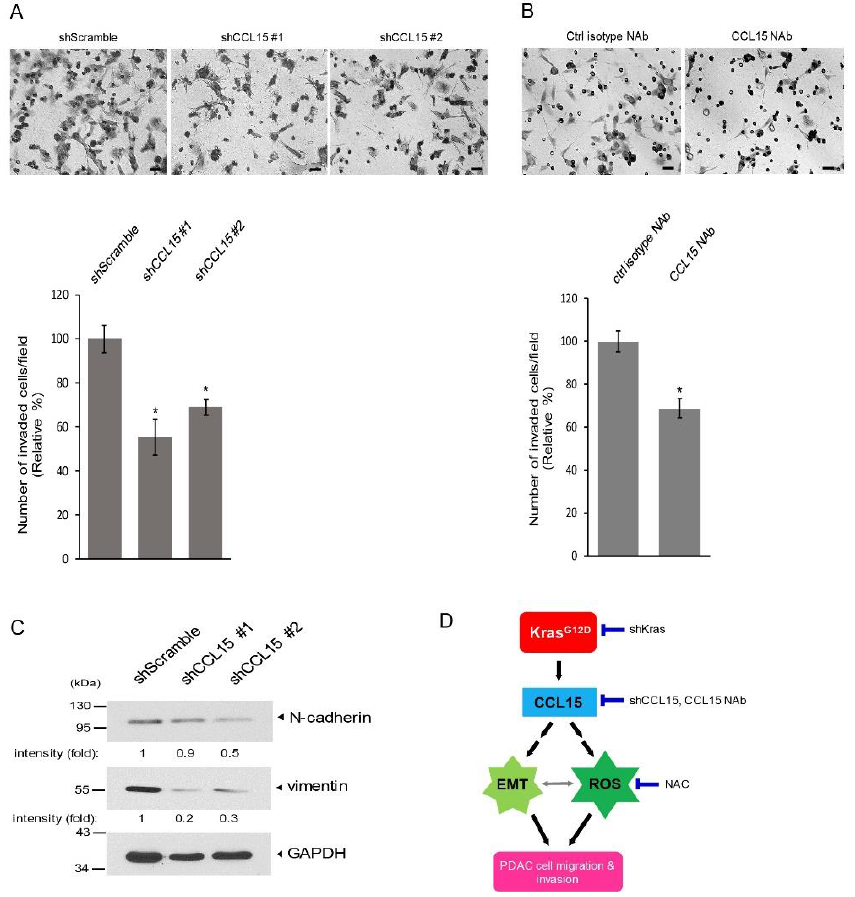
Figure 6. CCL15 accelerated PDAC cell invasion and regulated epithelial mesenchymal transition. ( A ) Human PDAC panc-1 cells stably expressing shScramble, shCCL15 #1, or shCCL15 #2 were sub- jected to a cell invasion assay as described in Section 2. The numbers of invaded Panc-1 cells in each condition were quantified by five randomly selected fields. The pictures shown are representative of three independent experiments. Scale bar: 50 µm. *: p < 0.05 as compared to shScramble. ( B ) Human PDAC panc-1 cells were subjected to a cell invasion assay in the presence of either a control isotype neutralizing antibody (NAb) or a CCL15 NAb. The numbers of invaded Panc-1 cells in each condition were quantified by five randomly selected fields. The pictures shown are representative of three independent experiments. Scale bar: 50 µm. *: p < 0.05 as compared to control NAb. ( C ) Expression levels of N-cadherin and vimentin in human PDAC Panc-1 cells that stably express shScramble, shCCL15 #1, or shCCL15 #2 were assessed by immunoblots. GAPDH levels were used as a control. Quantification result from 3 independent experiments is shown in Figure S8. ( D ) Schematic diagram to summarize findings. Original blots see supplementary File S1.